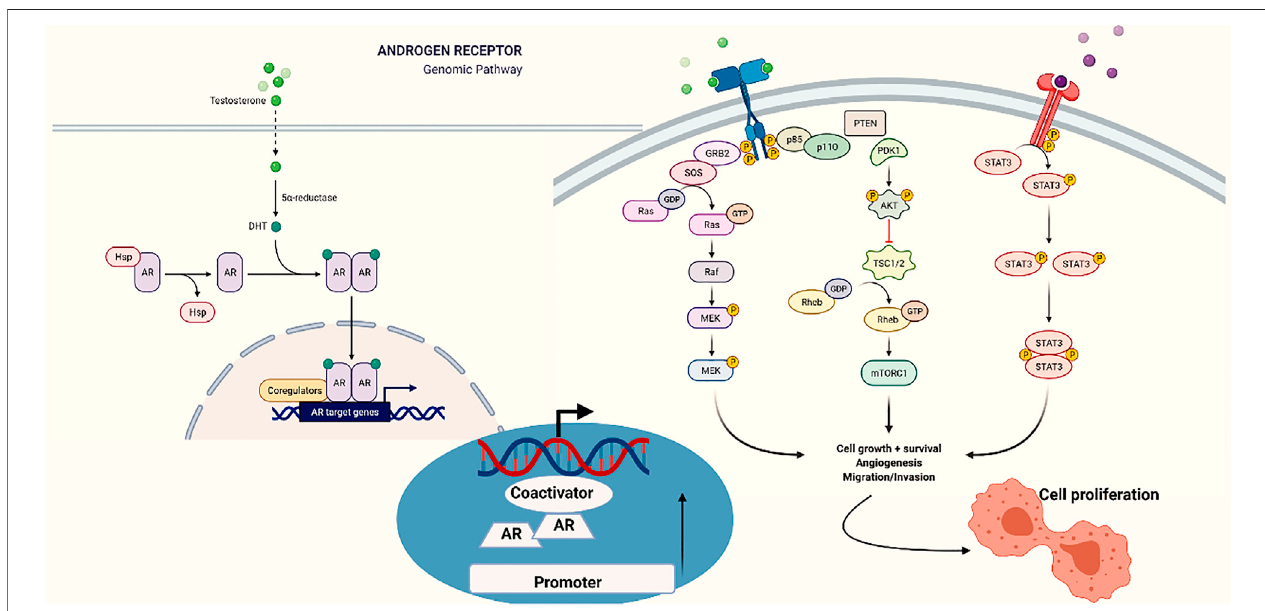
FIGURE 2 | Signaling pathways in castration-resistant prostate